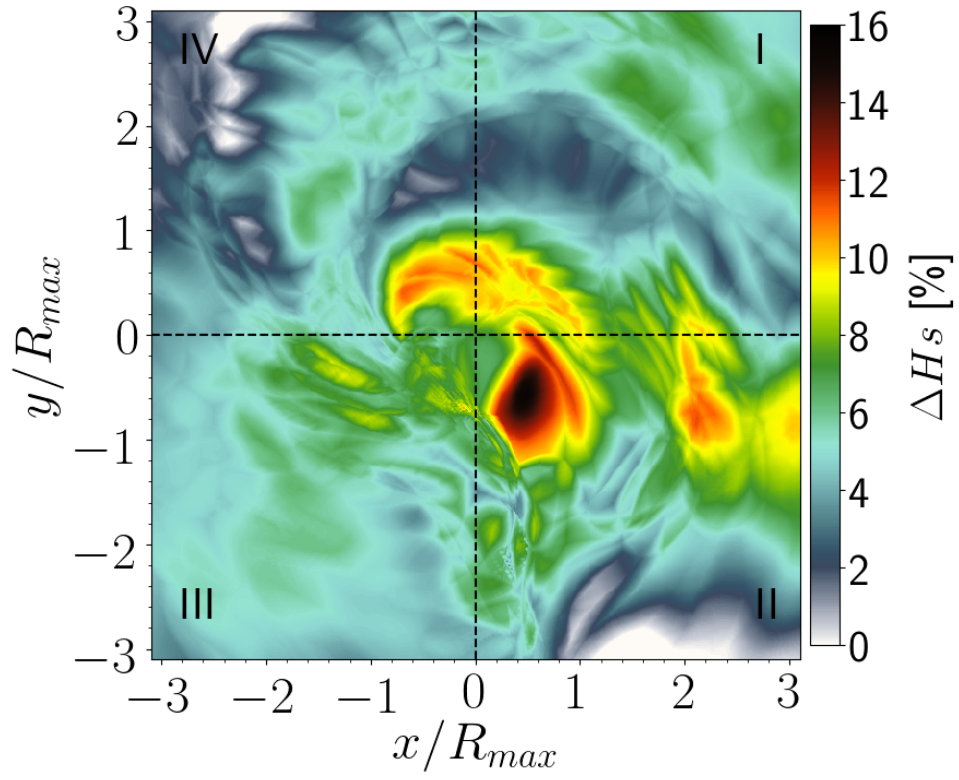
Figure 6. Differences (in percentage) between the 97.5 percentile values of the Hs calculated using the original winds minus those calculated using the filtered